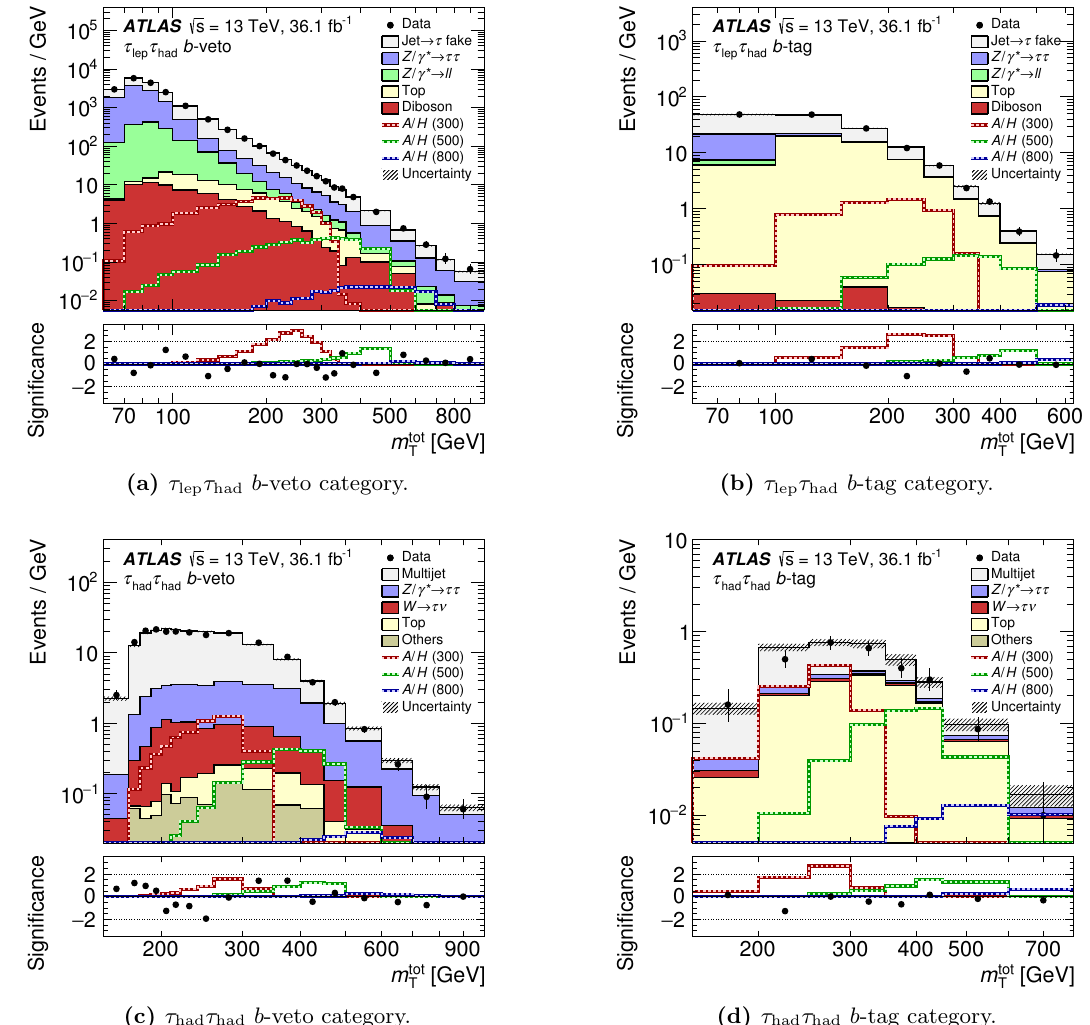
Figure 5. Distributions of m tot for the (a) b -veto and (b) b -tag categories of the (cid:28) lep (cid:28) had channel T and the (c) b -veto and (d) b -tag categories of the (cid:28) had (cid:28) had channel. The label \Others" refers to contributions from diboson, Z=(cid:13) (cid:3) ( ‘‘ )+jets and W ( ‘(cid:23) )+jets production. In the (cid:28) lep (cid:28) had ! !